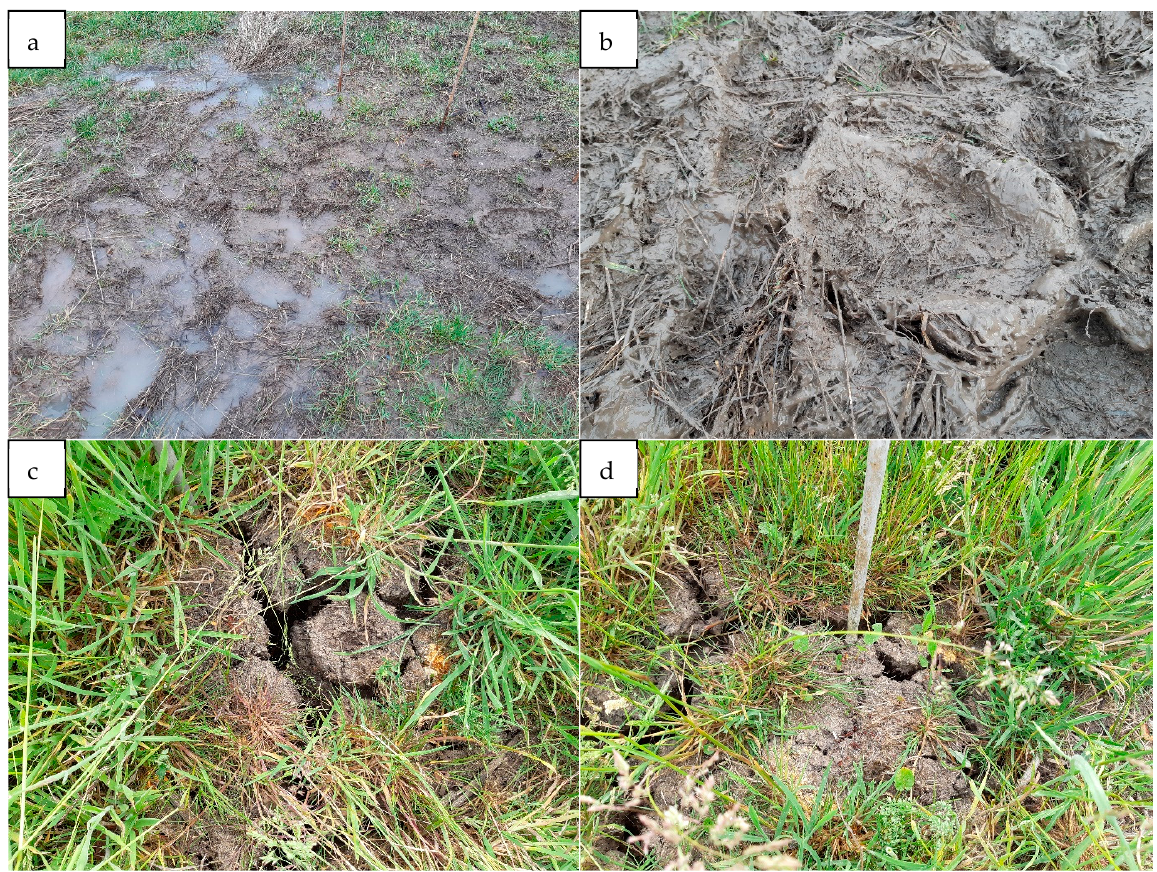
Figure 4. ( a , b ) saturation of the 2006 sample site throughout winter, ( c , d ) cracking of the 2006 and 2008 sample sites throughout summer.